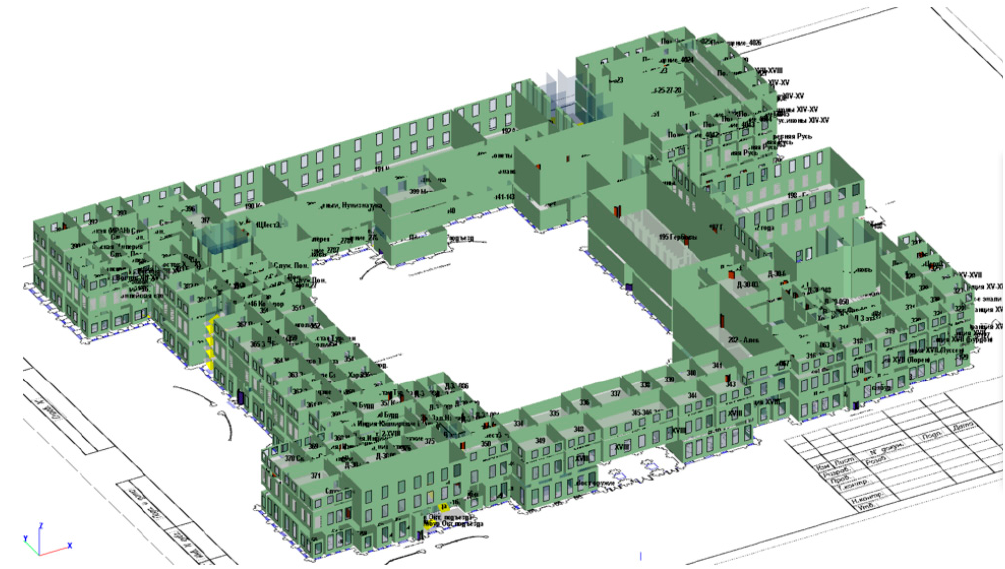
Figure 8. 3D model of the Winter Palace.